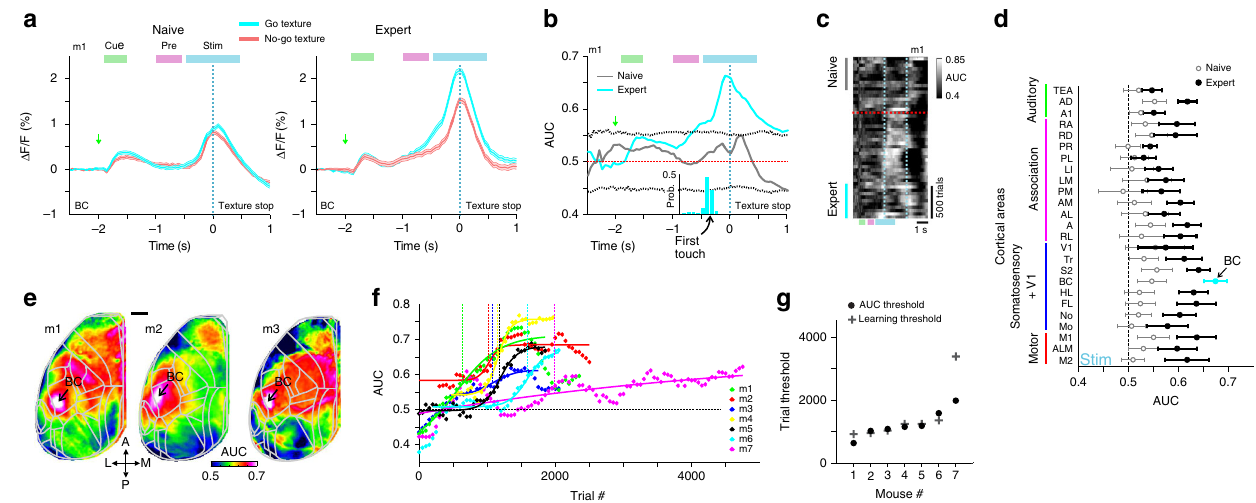
Fig. 7 Emergence of discrimination power in barrel cortex during learning. a BC activity in an example mouse for go (cyan) and no-go (red) trials in naïve (left) and expert (right) mouse. Error bars are s.e.m. across trials. b ROC-AUC values for go vs. no-go trials as a function of time for naïve (gray) and expert (cyan) mice. Dashed gray lines indicate mean ± 2 s.d. of shuf fl ed data. Same example as in a . Histogram below depicts the distribution of the fi rst touch for the expert case in this example. c Heat map of trial-related AUC values across learning dimension (vertical axis) in the same example mouse. Dashed red line indicates learning threshold. Dashed cyan lines indicate texture-in period. d Pooled AUC values during stim-period in all areas for expert (blue) and naïve (black) mice. Error bars are s.e.m. across mice. e AUC maps during stim-period in three example expert mice. Color denotes AUC values. Scale bar is 1 mm. f AUC values in BC during stim-period across learning for all mice. Threshold for each mouse is indicated with a vertical line at the in fl ection point of the sigmoid fi t. g In fl ection points of AUC curves de fi ning ‘ AUC thresholds ’ . Learning thresholds are marked with gray plus